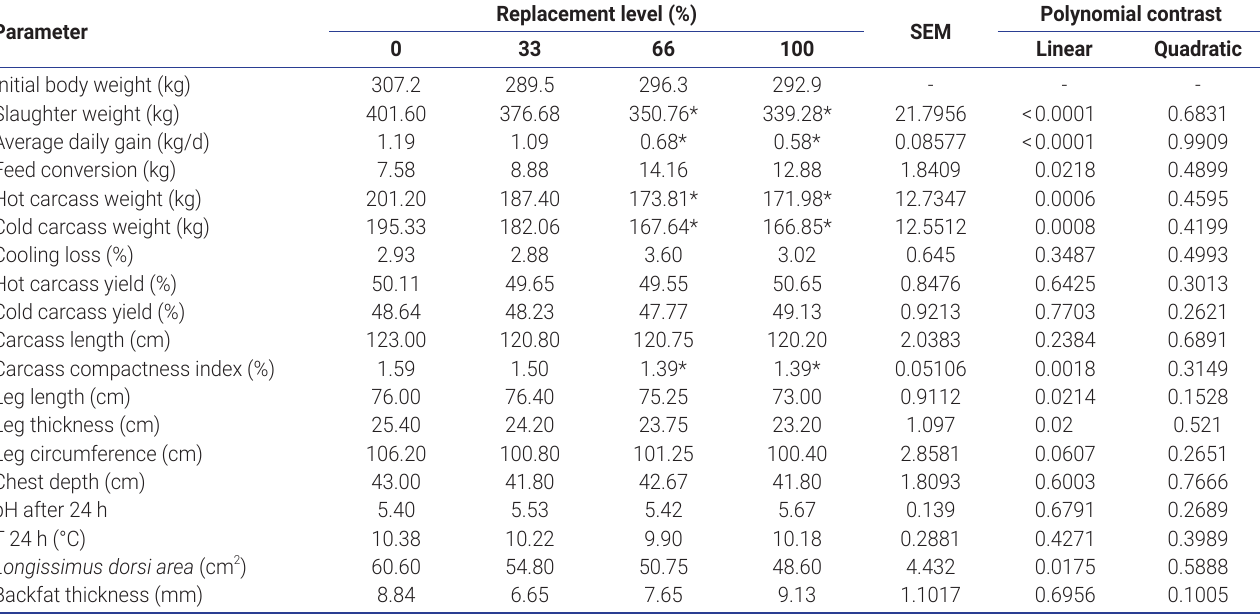
Table 2. Performance and carcass characteristics of buffaloes fed sugarcane-based diets supplemented with spineless cactus replacing wheat bran